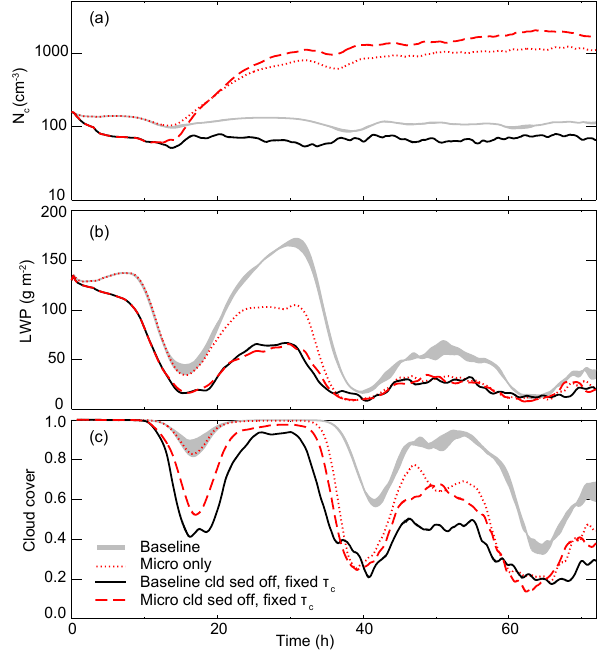
Figure 4. As in Fig. 2 with the baseline in gray and with over- lying aerosol that does not affect radiation shown with dotted red line. Baseline and overlying aerosol cases in the absence of cloud- droplet sedimentation and with a fixed relaxation time for diffu- sional growth of cloud droplets ( τ c ) are shown with black solid and red dashed lines, respectively.